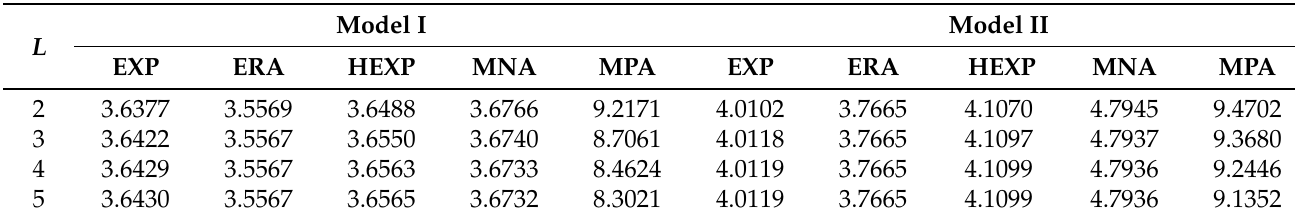
Table 6. Effect of L on expected waiting time of P 2 customers in the system (when θ = 0.6).